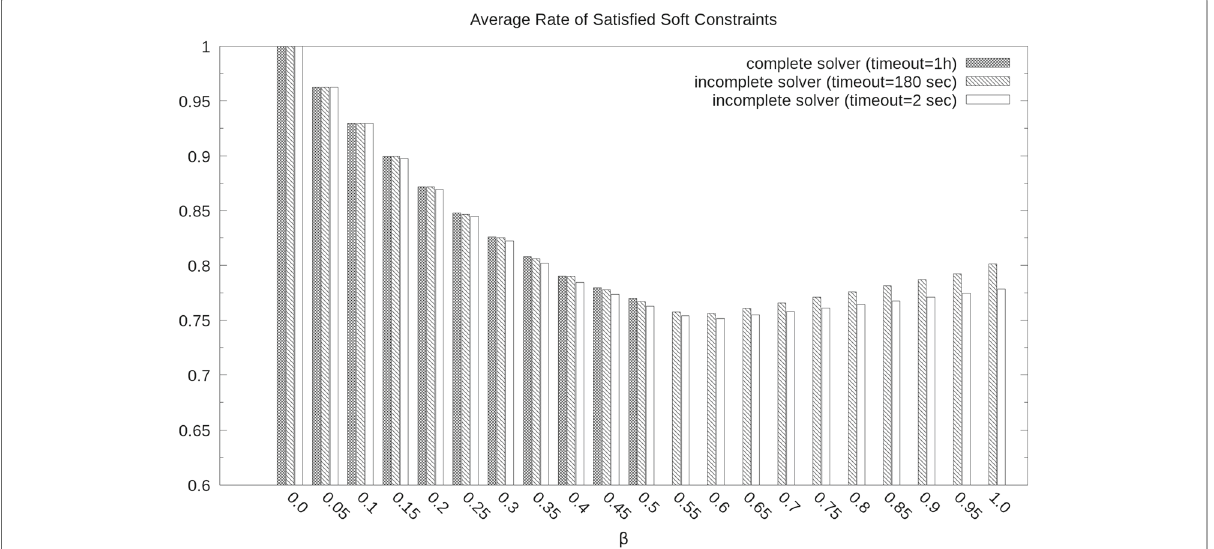
Fig. 3 Average percentage of satisfied soft clauses (y axis) as a function of the balance β (x axis) in the SmallComp